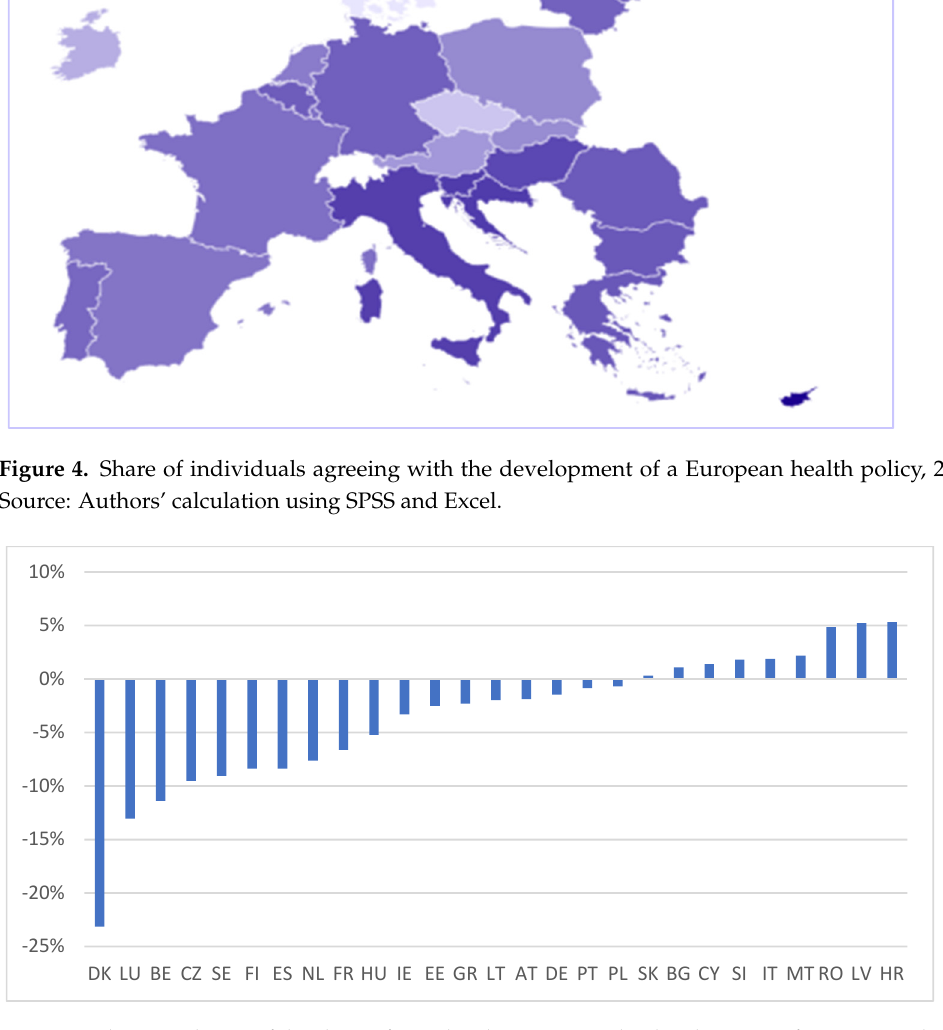
Figure 5. The growth rate of the share of people who prioritize the development of a European health policy, 2021 compared to 2020. Source: Authors’ calculation using SPSS and Excel.